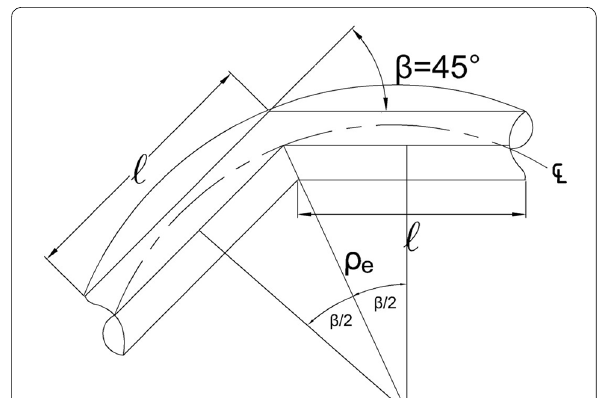
Fig. 14 Bend angle and centre line curvature.